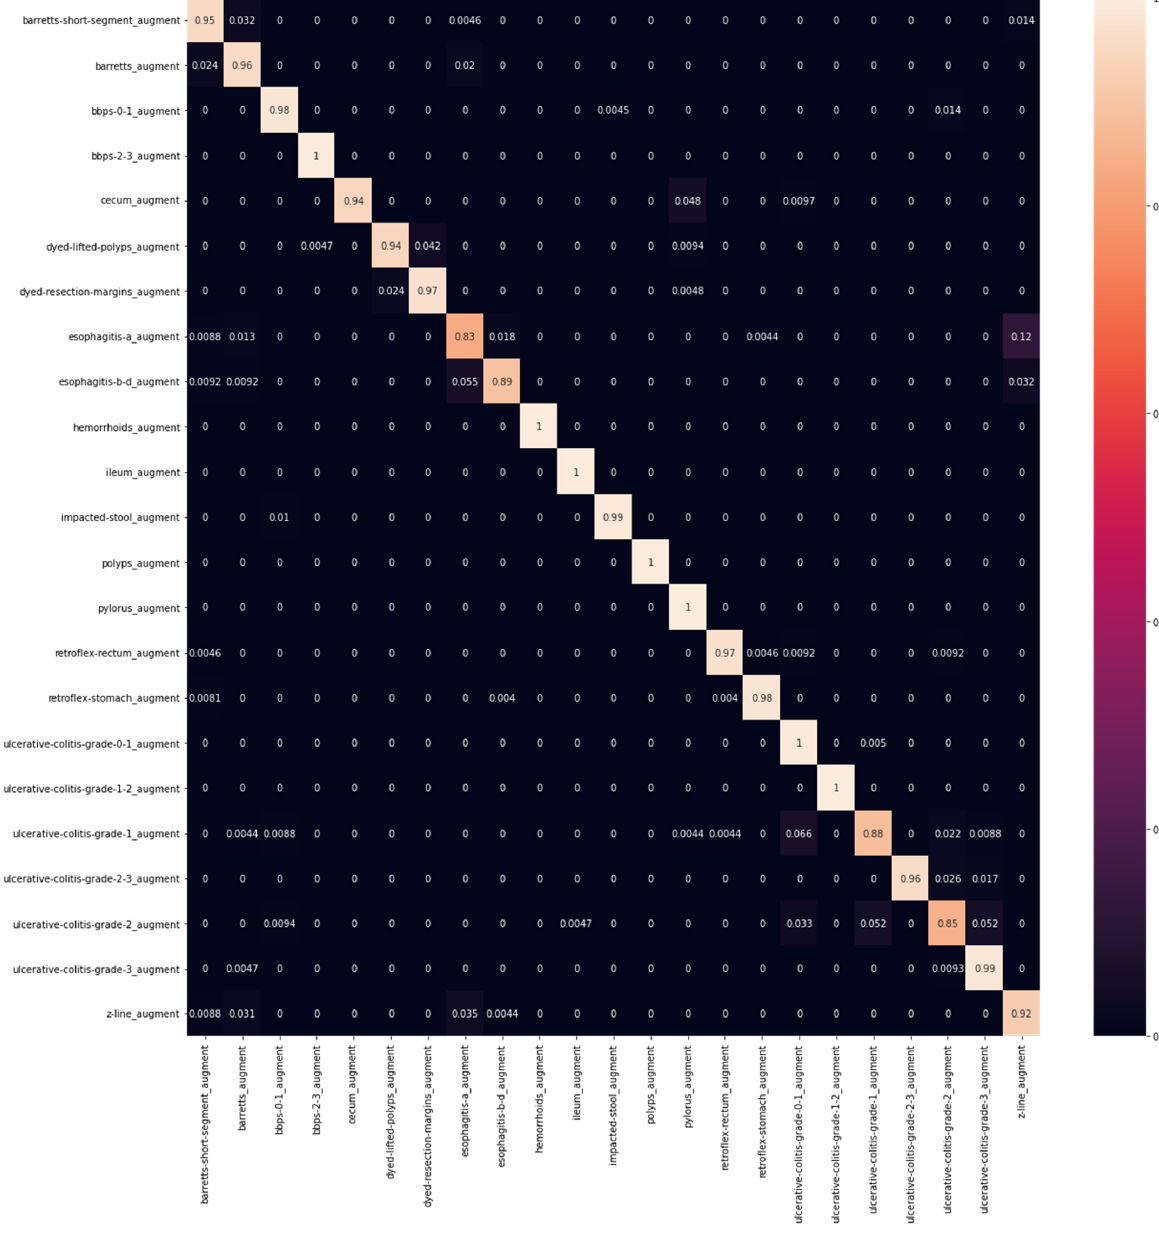
Figure 9. Confusion matrix. Table 2. Summary of the ablation studies